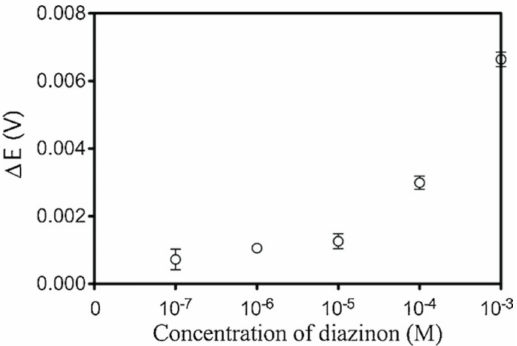
Figure 16. Calibration plots for organophosphate pesticide (diazinon). Reprinted with permission of reference [54]. Copyright 2015 Elsevier B.V.